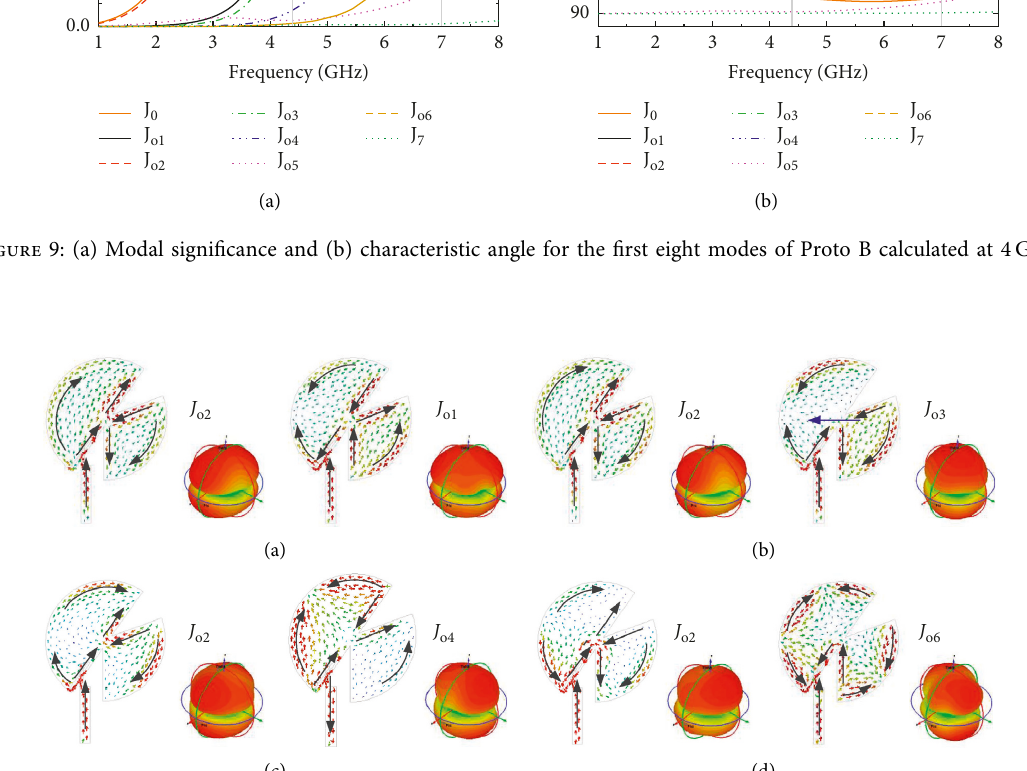
o 1 and J o 2 at 4.4GHz. (b) Modes J o 2 and J o 3 at 4.6GHz. (c) Modes